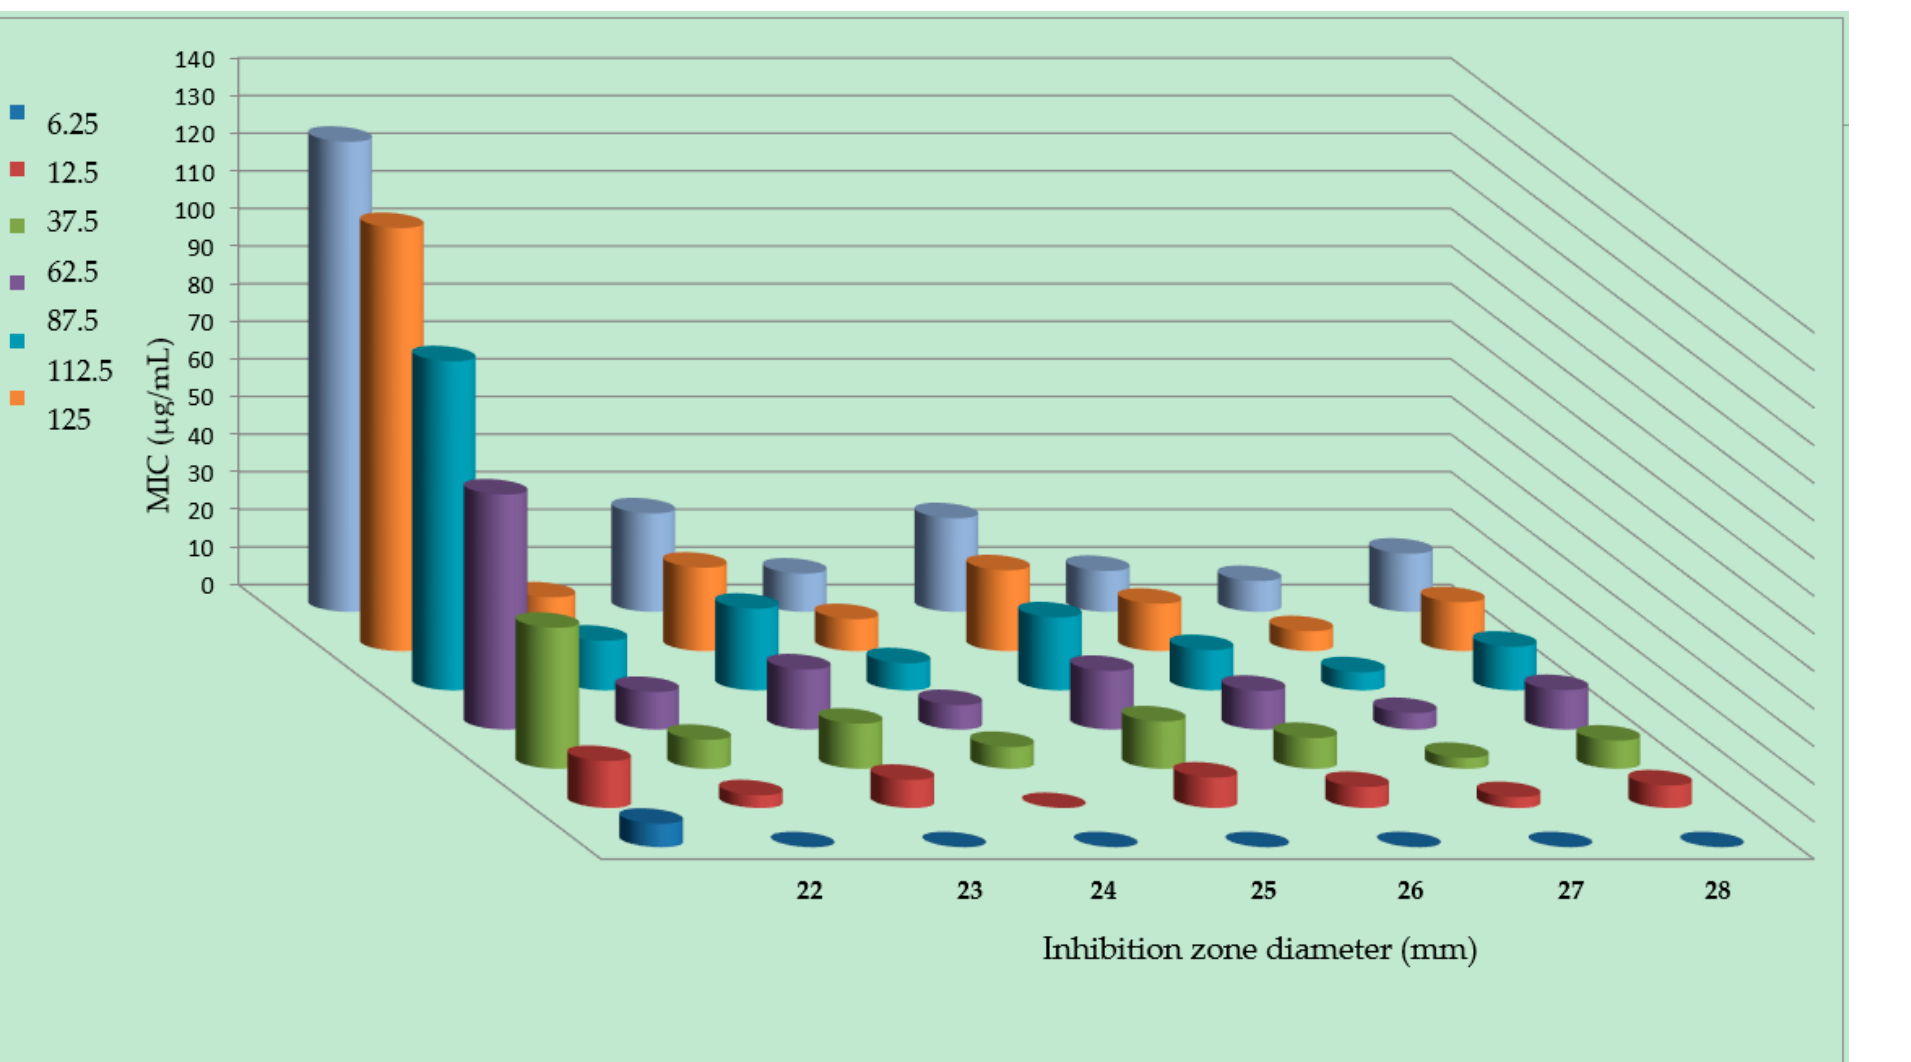
Figure 3. Antibacterial susceptibility of species E. coli given as MICs values in µ g/mL for compounds 22 –